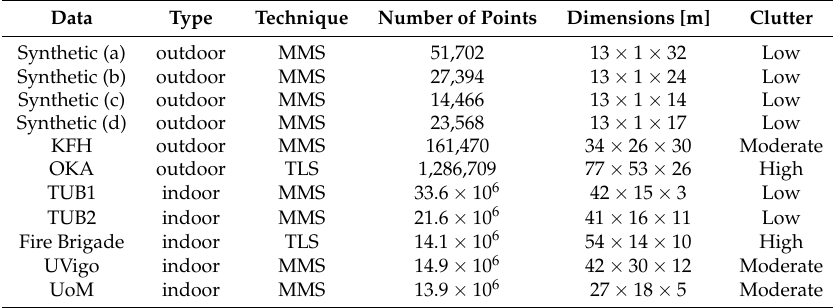
Table 1. Specifications of point